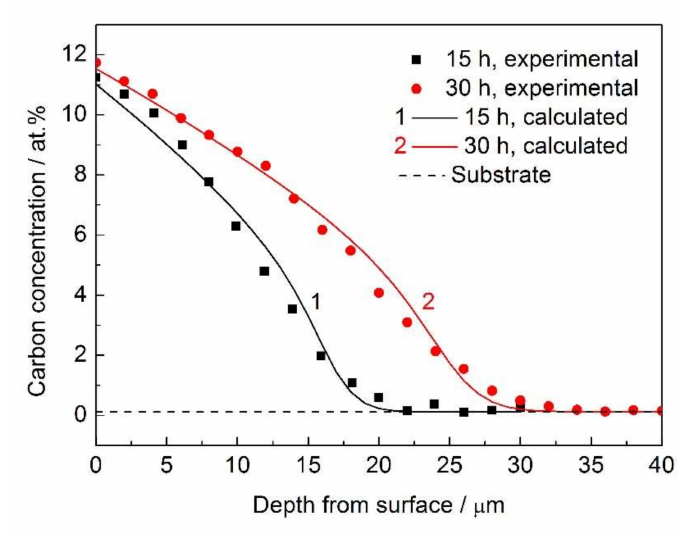
Figure 2. Experimental and calculated carbon concentration–depth profiles of AISI 316L carburized at 470 ◦ C for 15 h and 30 h.